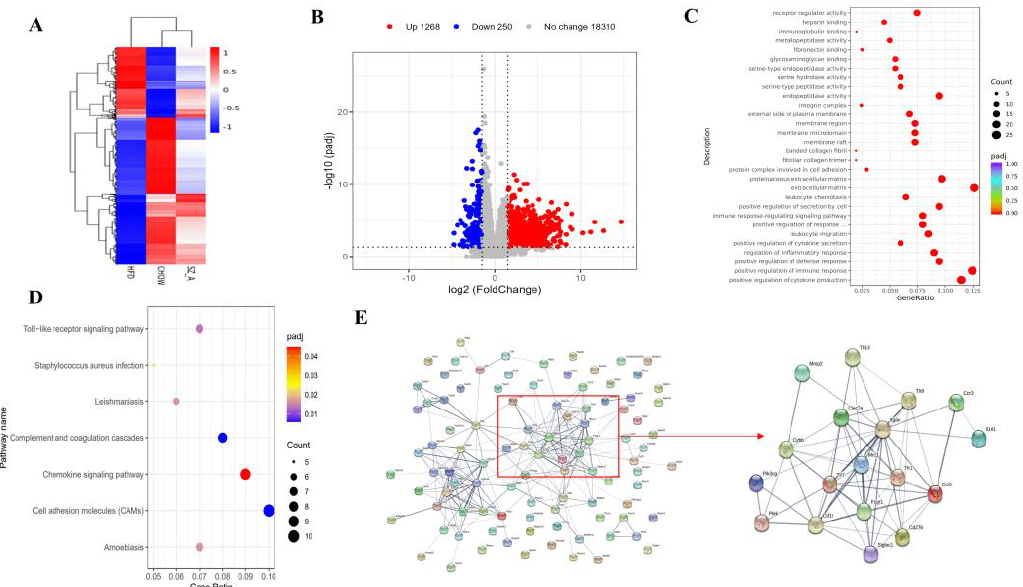
Figure 3. ( A ) Heatmap of NC, HFD, and SZ-A groups differential genes (Padj < 0.05, |log2(foldchange)|> 1.5) in eWAT ( B ) Volcano plot of the differentially expressed genes (Padj < 0.05, |log2(foldchange)| > 1.5) in eWAT of HFD control and SZ-A group ( n = 7/group). Red and blue represent the high and low expression of genes in the SZ-A group, respectively. ( C ) GO analysis on the down-regulated genes in the SZ-A group. ( D ) KEGG analysis on the down-regulated genes in the SZ-A group. ( E ) Protein-protein interaction network analysis of the top 100 differential genes using String database.